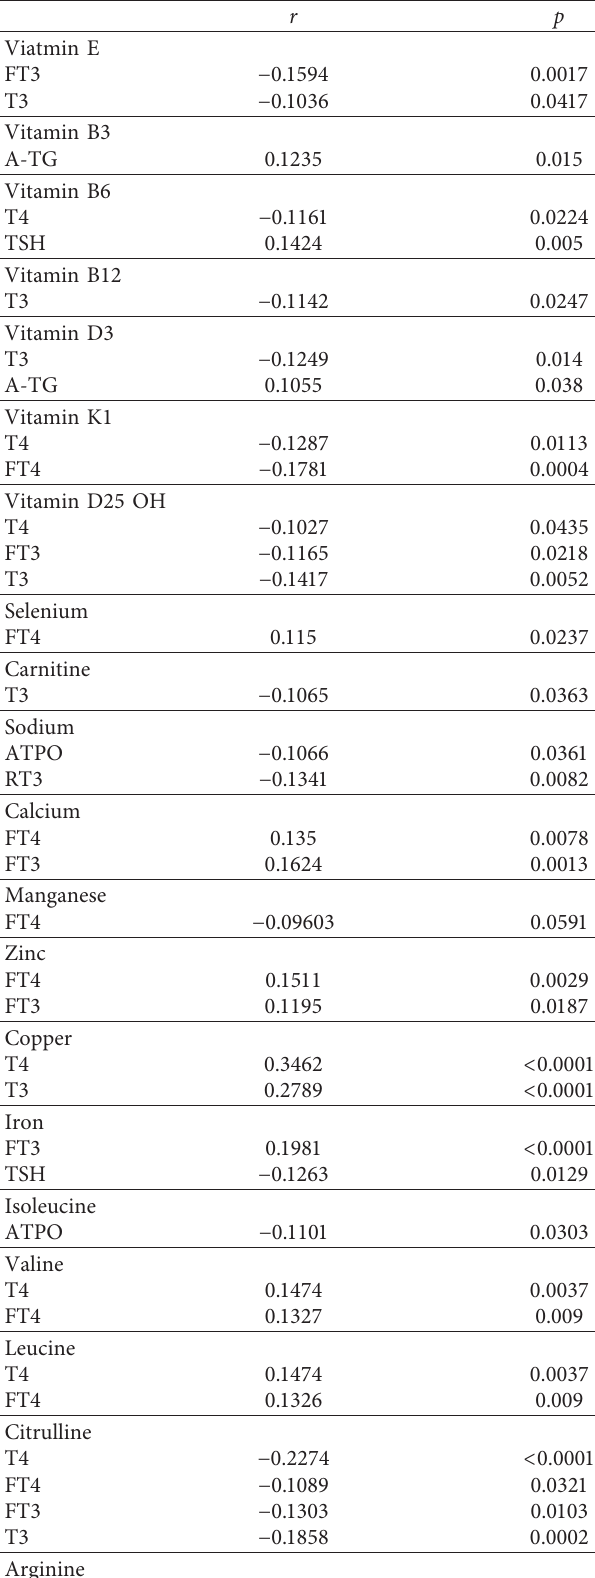
Table 3: Micronutrients with significant Pearson’s r correlation with thyroid